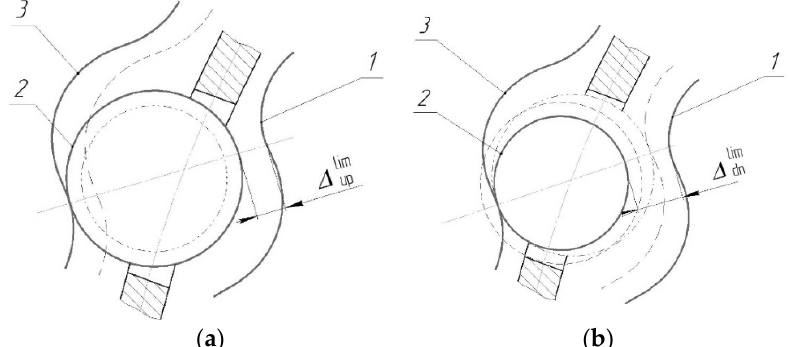
Figure 5. Cases of emergence of maximum manufacturing clearances in the engagement of a transmission with IREFC: 1—cam; 2—intermediate rolling elements; 3—ring; ( a ) maximum upper clearance; ( b ) maximum lower clearance.